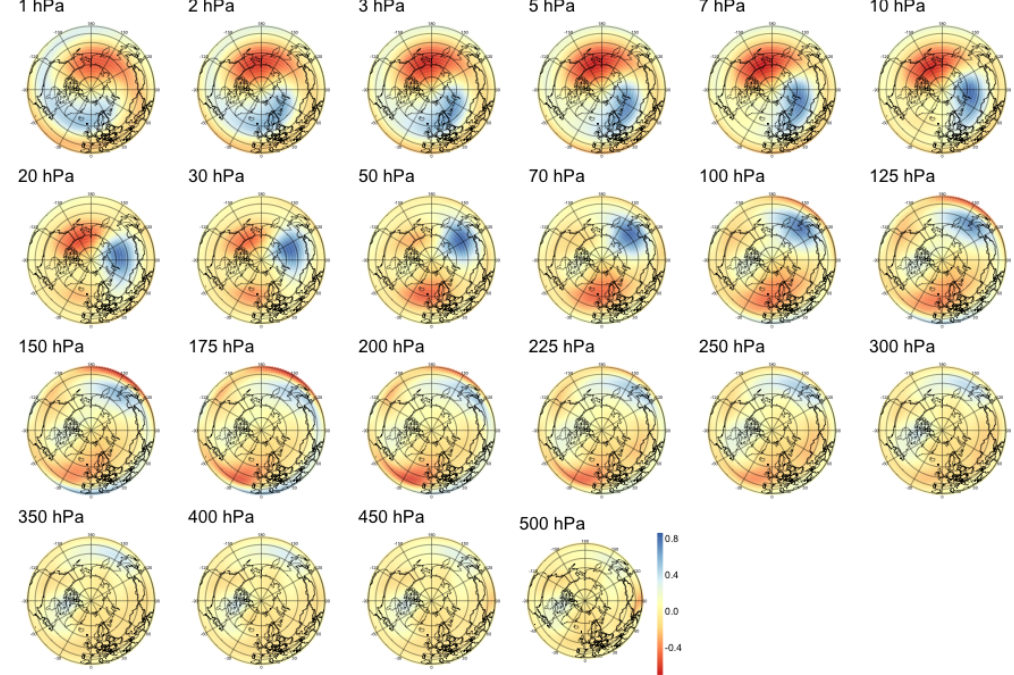
Figure B8. Pattern of PV waves maximizing correlation with the SSW index at a lead time of 30d.